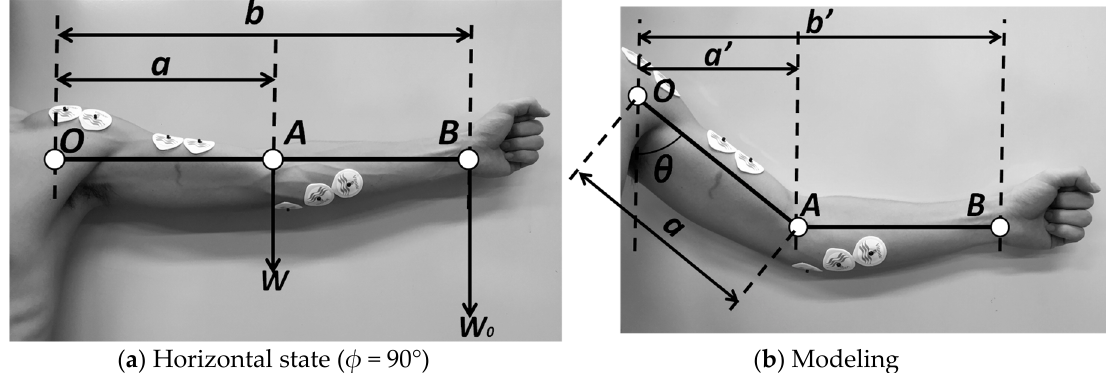
Figure 6. Model of arm.